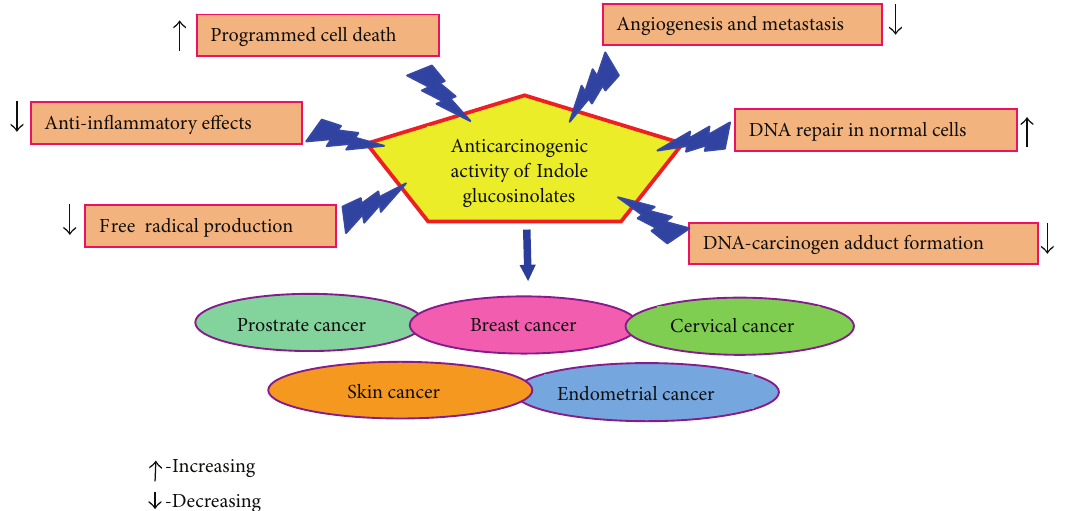
Figure 2: Sources of anticancer effect of indole glucosinolates (I3C and DIM) and its mode of